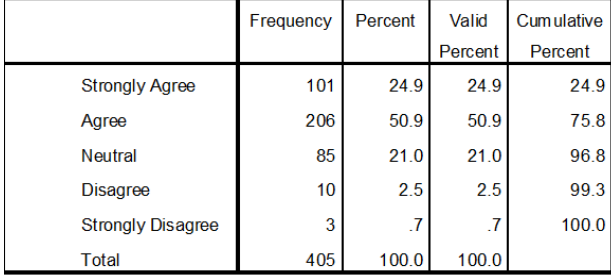
Figure 35. We provide on time, reliable service and back end support in case of